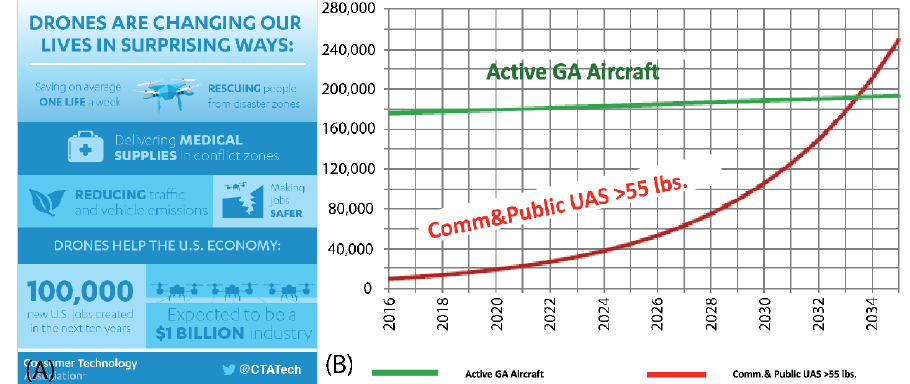
Figure 1. ( A ) Impact of the Unmanned Aircraft Systems (UAS) industry © 2018, CTA™ [5] (p. 4) and ( B ) Federal Aviation Administration (FAA) prediction of General Aviation (GA) UAS over 55 lbs. © 2018, CTA™ [4] (p. 8).